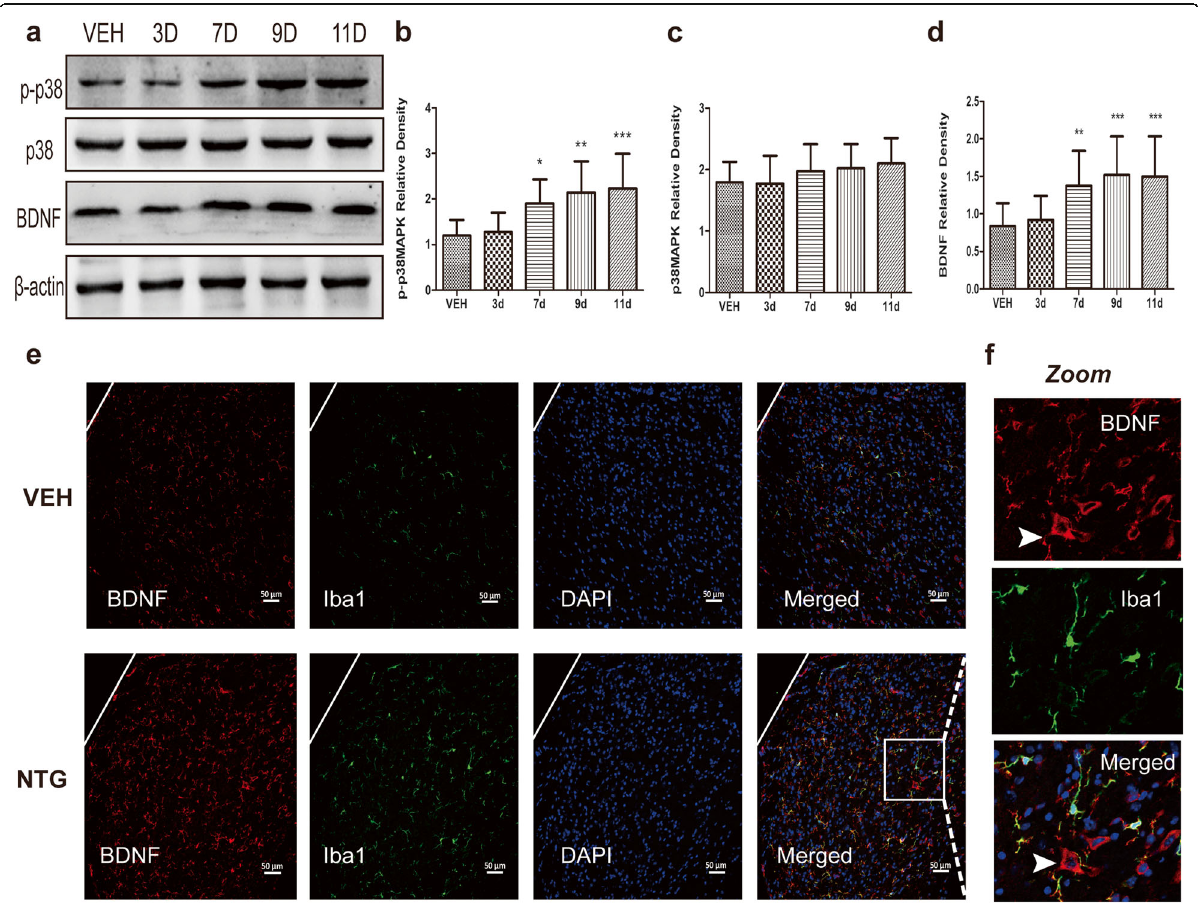
Fig. 7 Effect of NTG on p38, p-p38MAPK and BDNF levels in the TNC. a Representative images of Western blot results showing the p38, p- p38MAPK and BDNF protein levels from 3 d to 11 d during the NTG injection. b - d The histogram presents the quantitative analysis of p-p38 ( b ), p38MAPK ( c ) and BDNF ( d ) in the TNC. Data are presented as the mean ± SD. One-way ANOVA and Tukey ’ s multiple comparison test. * p < 0.05, ** p < 0.01, *** p < 0.001 versus VEH. e Representative photographs of immunofluorescence staining for BDNF (green) and microglia (Iba-1, red) in the TNC in the VEH and NTG groups on day 11. Scale bar = 50 μ m. f The white box was amplified. Scale bar = 20 μ m. The white arrow